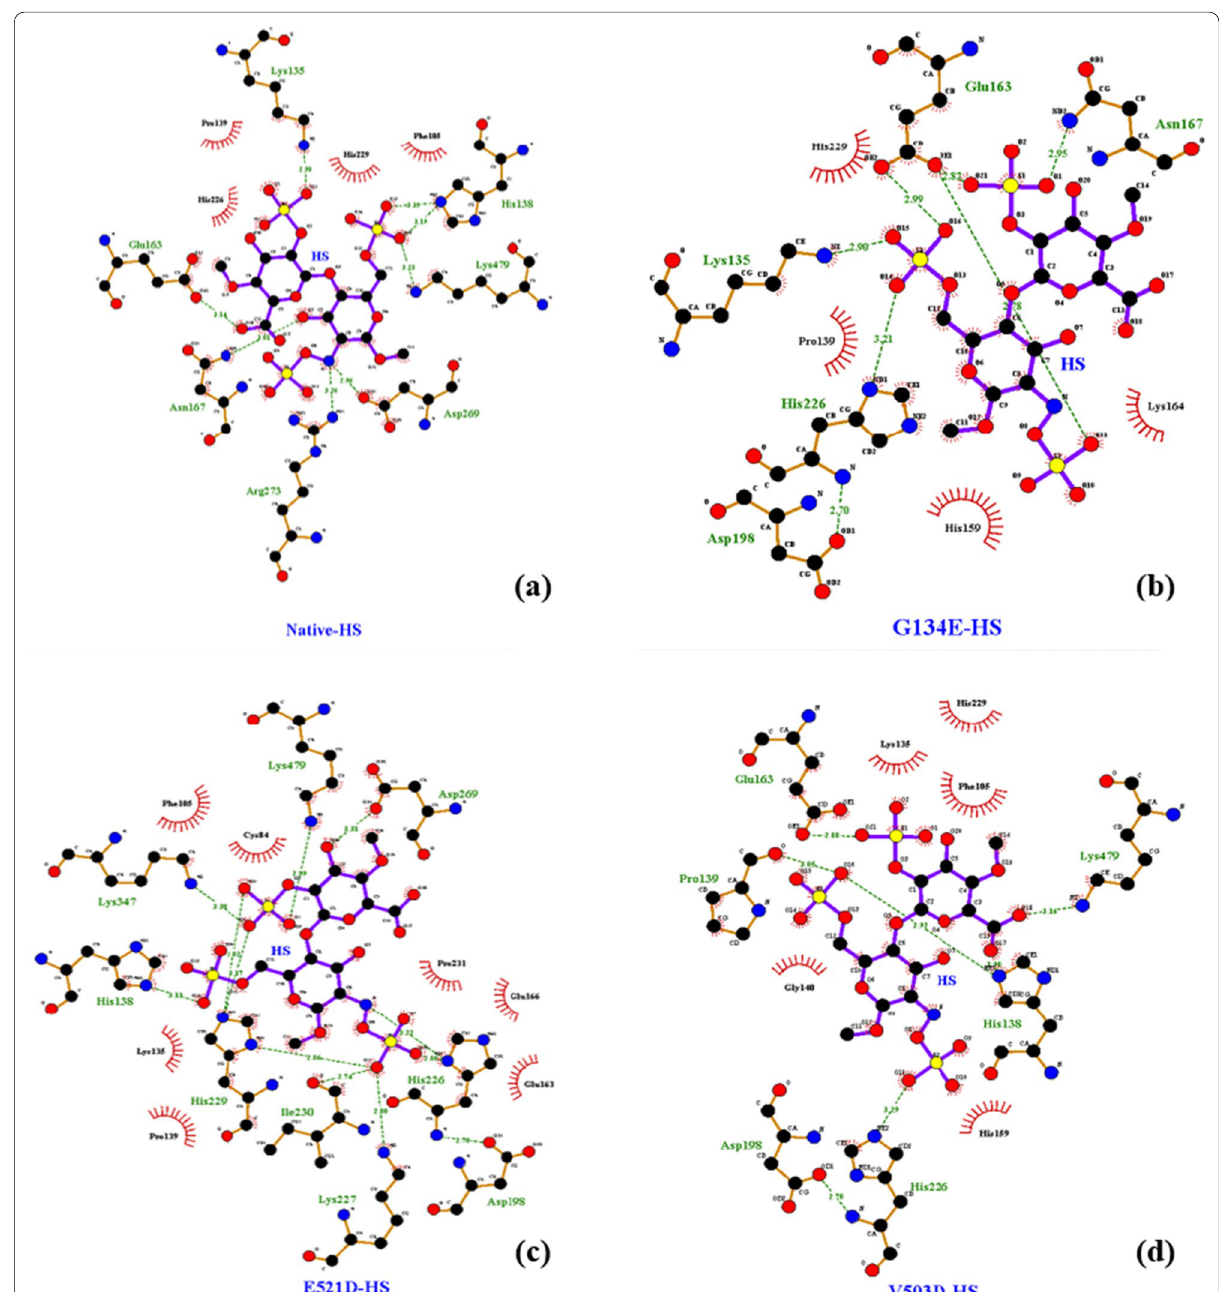
Fig. 1 Pictorial representation of the analysis using Ligplot E521D‑HS